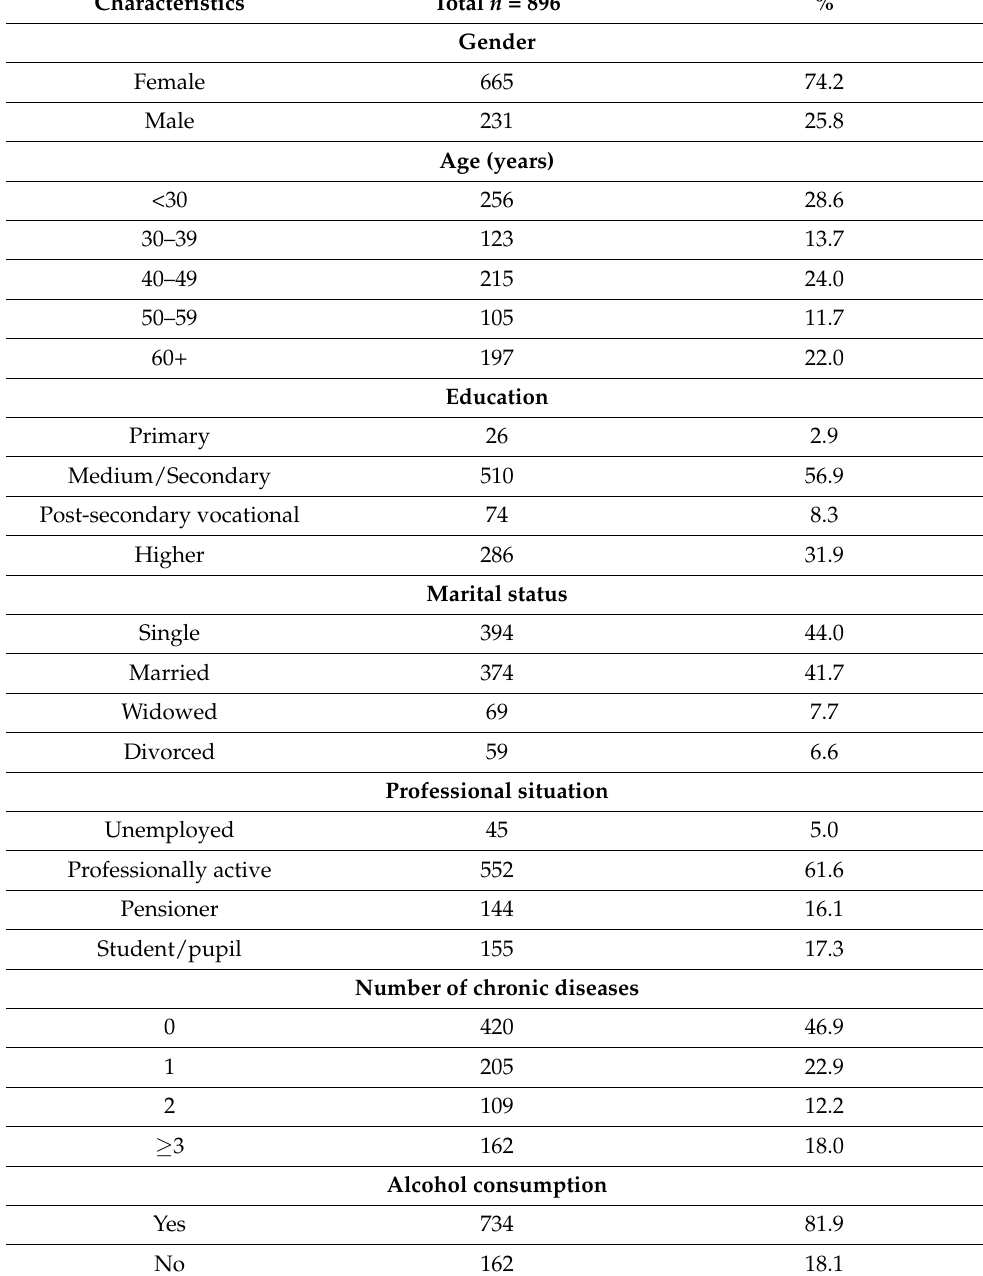
Table 1. Characteristics of the studied